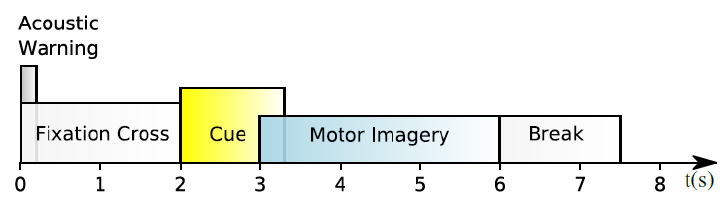
Figure 2. Timing pattern of the BCI Competition IV-2a.